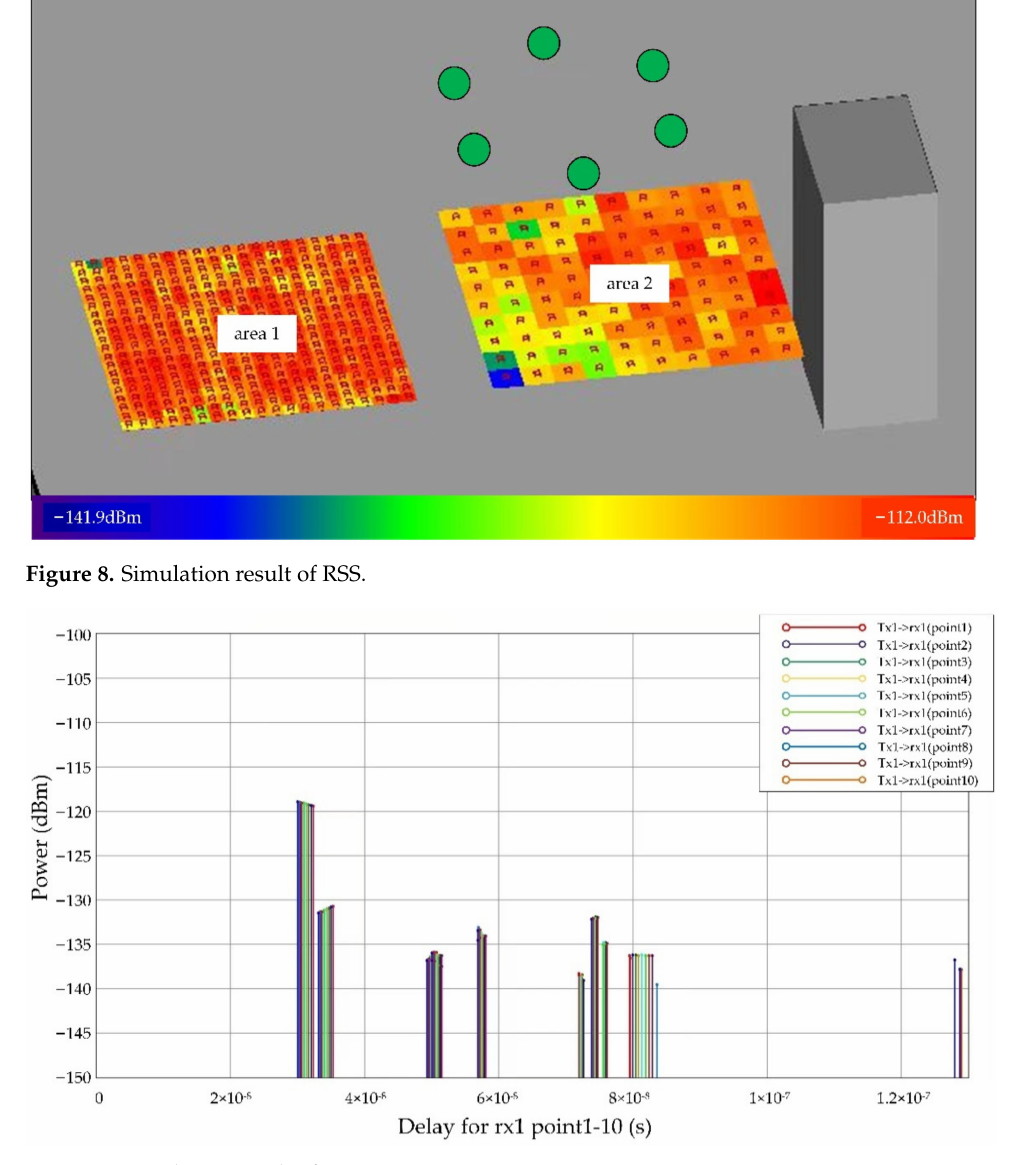
Figure 9. Simulation result of